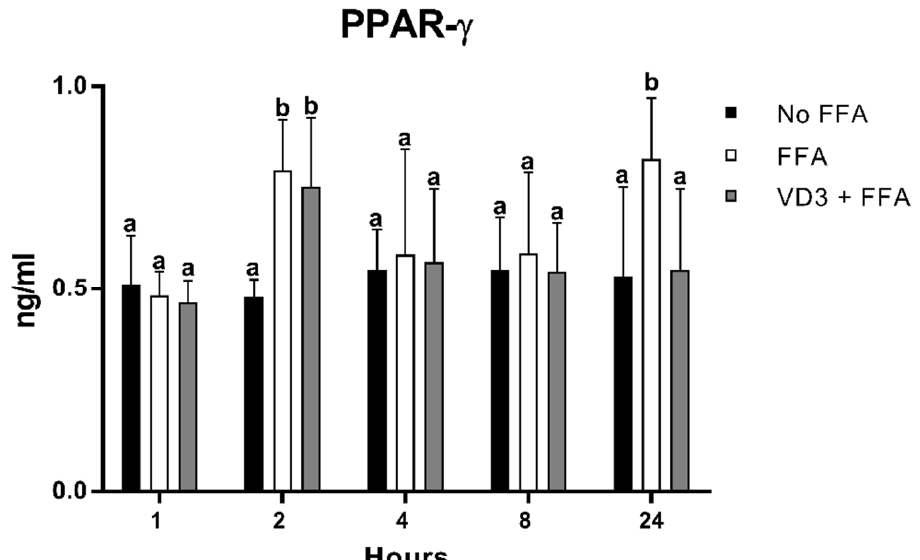
Figure 4. Effect of VD3 supplementation on PPAR- γ 1 protein levels. Data are reported as mean ± standard deviation. a,b Bar graphs with different letters are significantly different ( p ≤ 0.01). No FFA: no free fatty acids (control); FFA: free fatty acids (500 μ M); VD3: calcitriol (50 nM).